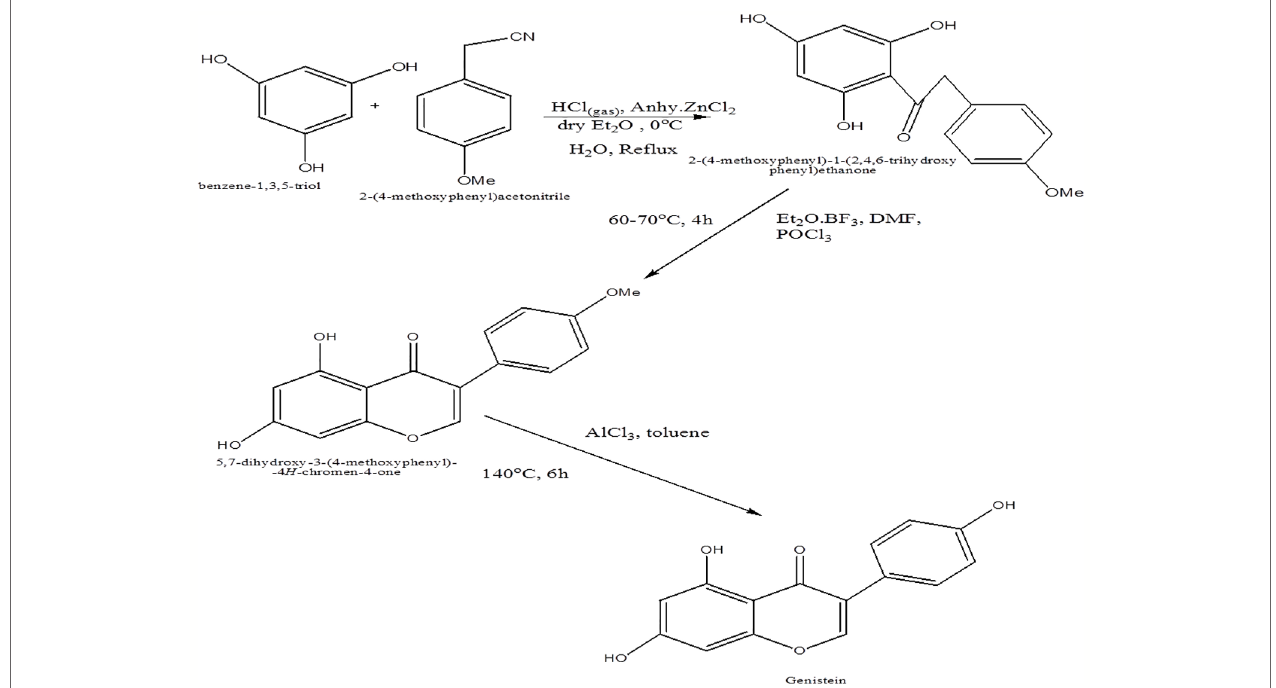
FIGURe 2 | Synthesis route of genistein via